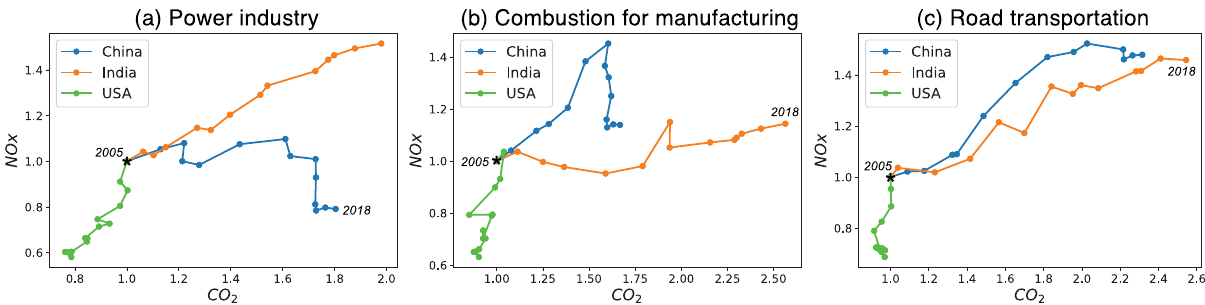
Fig.4|Co-evolutionofsectoralemissionsofCO 2 andNO x . SameasFig.3a,butforNO x /CO 2 emissionchangesforeachemissionsectorseparately:( a )powerindustry,( b ) combustion for manufacturing, and ( c ) road